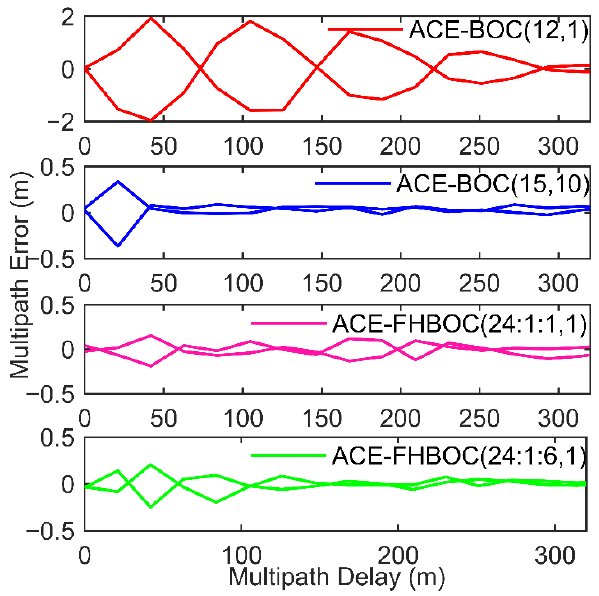
Figure 16. NELP multipath errors for the example signals.